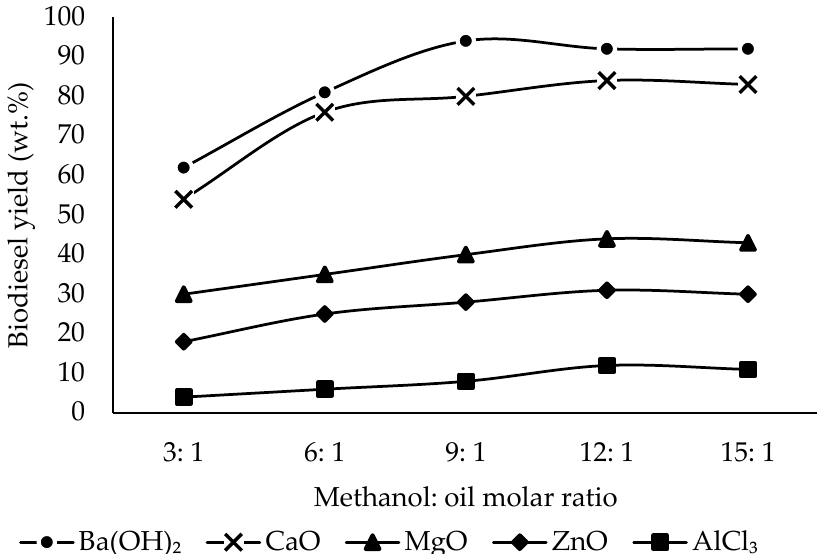
Figure 6. Effect of methanol-to-oil molar ratio on biodiesel yield. (Catalyst loading 5 wt.%; temperature 60 °C; time 120 min, speed 600 rpm.)